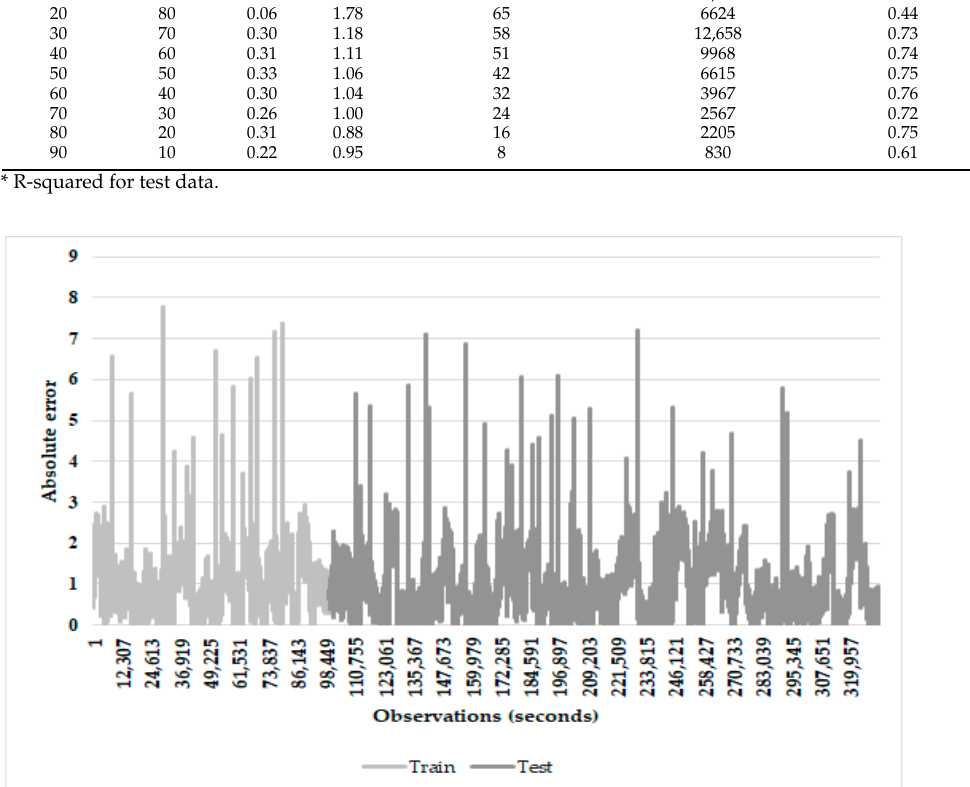
Figure 2. Absolute error versus observations in seconds for the two-state Markov-switching dynamic regression model with a 30%/70% training/testing split.